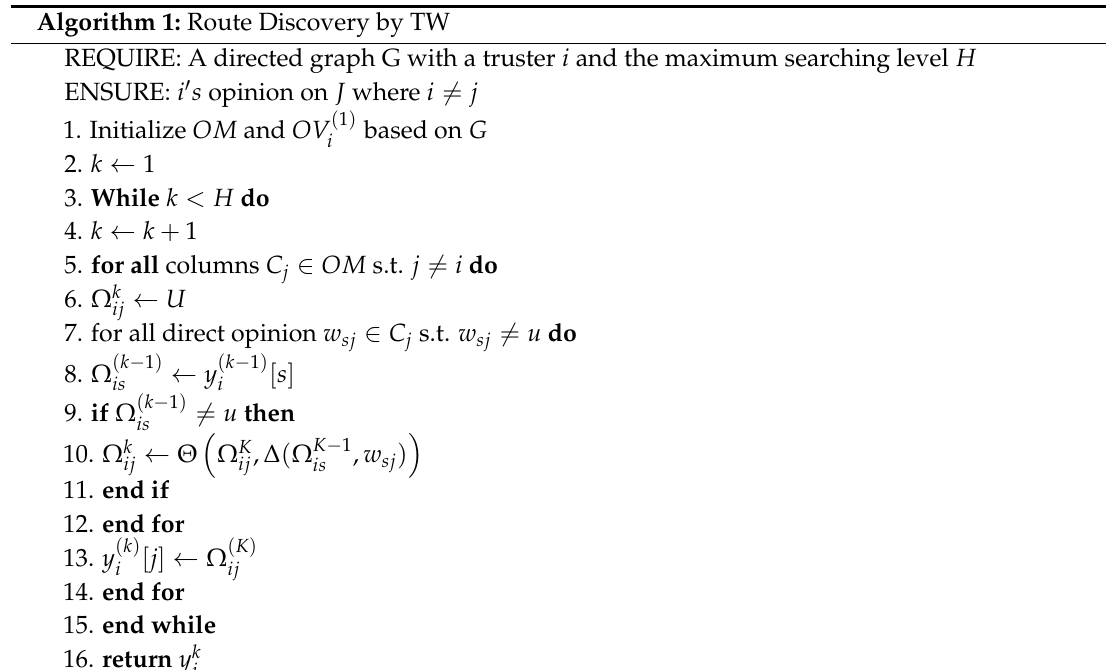
Algorithm 1: Route Discovery by TW